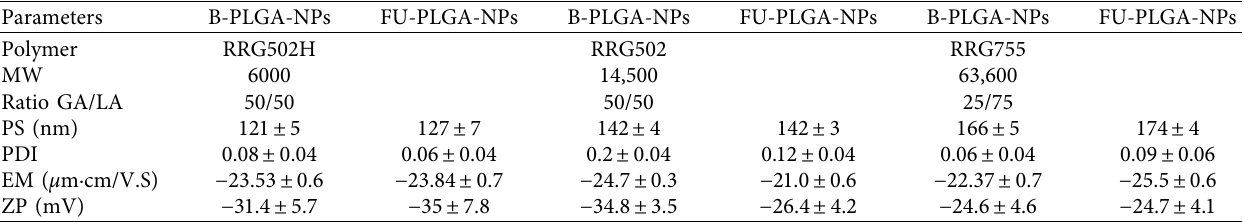
Table 1: Lists of the physical and chemical properties of several NP preparation made either with or without, i.e., blank FU (B-PLGA-NPs) (FU-PLGA-NPs).